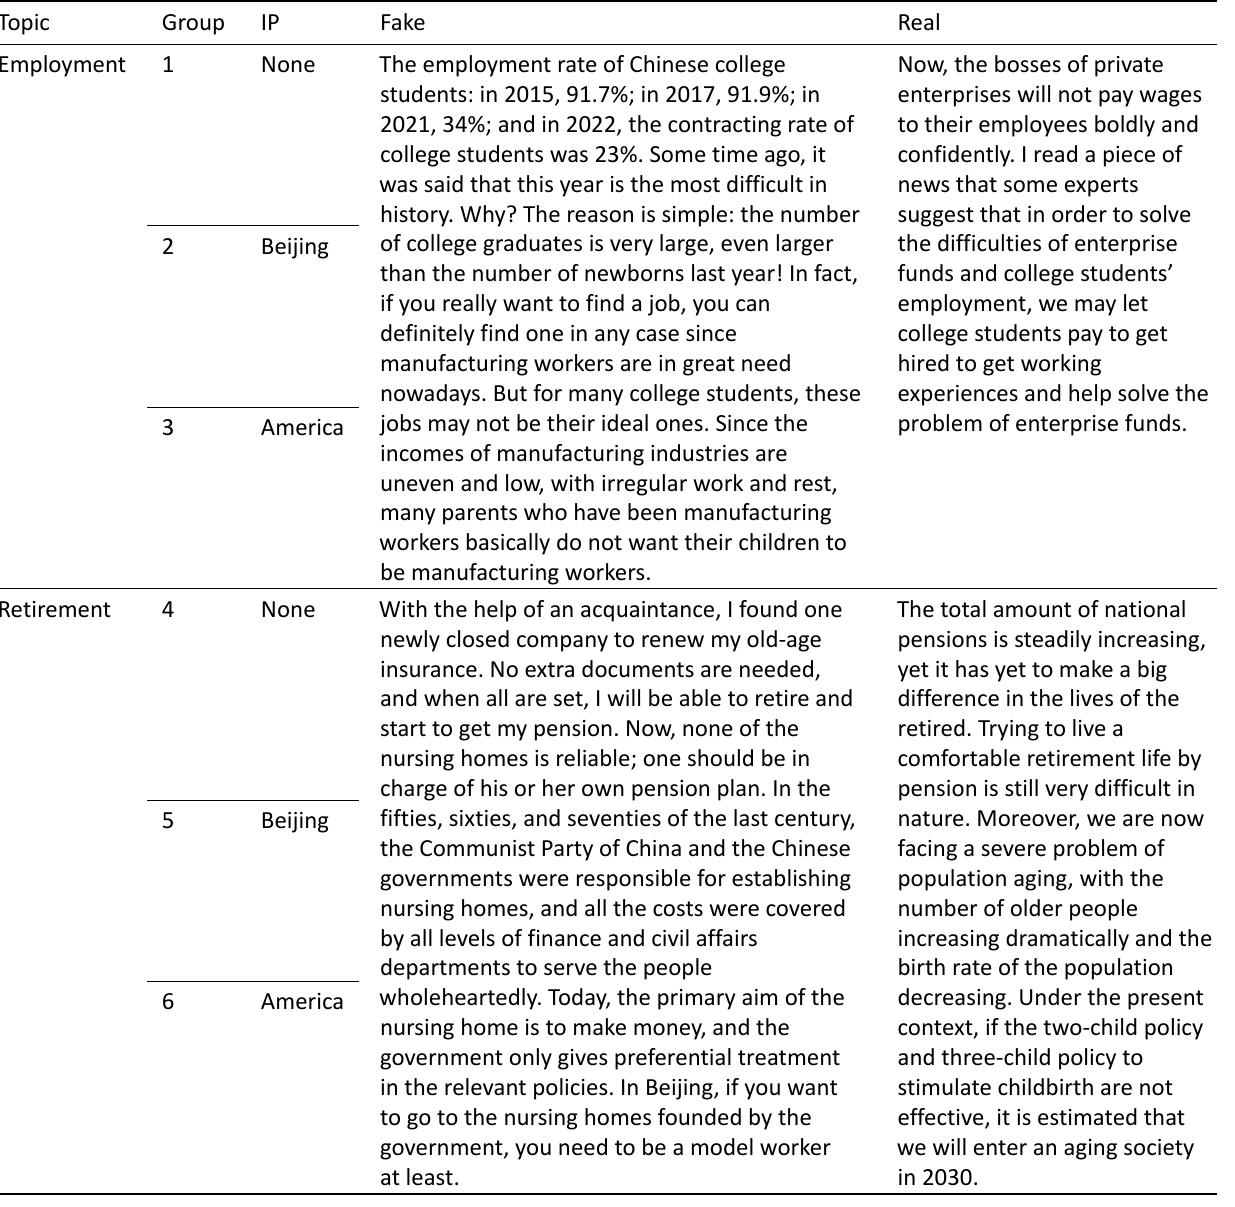
Table 2. Screenshot contents of Weibo for each group. Topic Group IP Fake